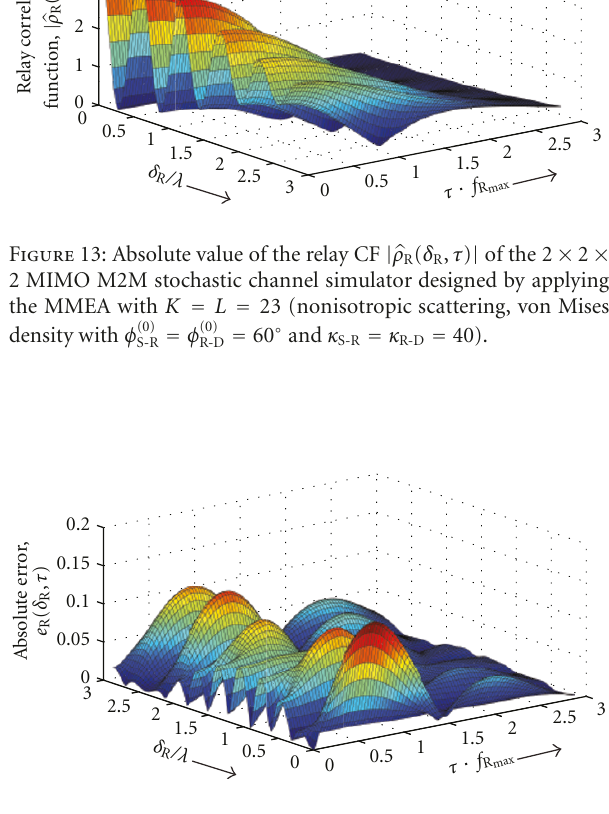
= φ (0) = 60 ◦ and κ = κ = S-R R-D S-R R-D